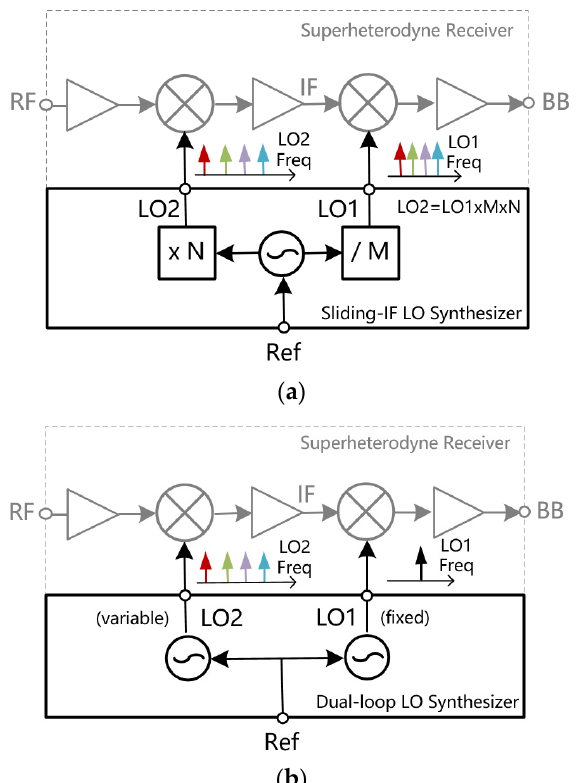
Figure 2. Schematic of the super-heterodyne receiver with ( a ) the sliding-IF LO synthesizer; ( b ) the proposed dual-loop LO synthesizer.